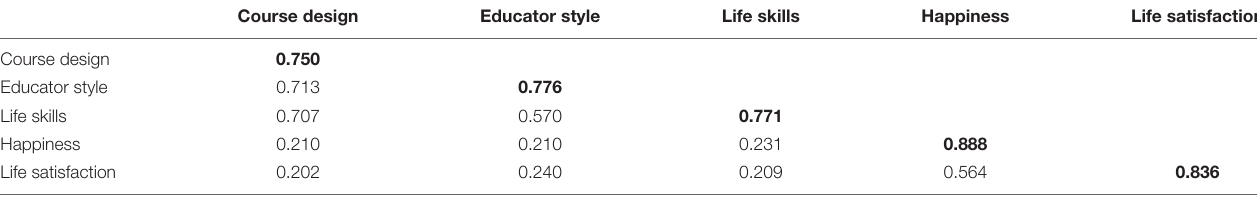
TABLE 3 | The Fornell-Larcker Criterion Test for discriminant validity which requires values in bold to be greater than the remaining values in each column.